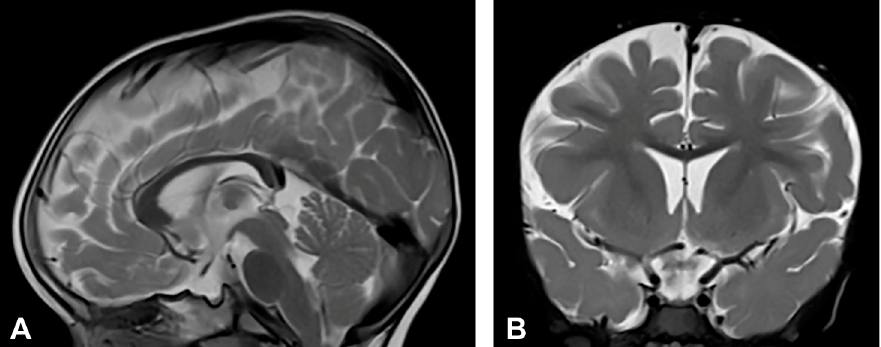
Figure 6. (Case 6) ( A ) Sagittal and ( B ) coronal T2W magnetic resonance images at the age of one and a half without pathological findings.